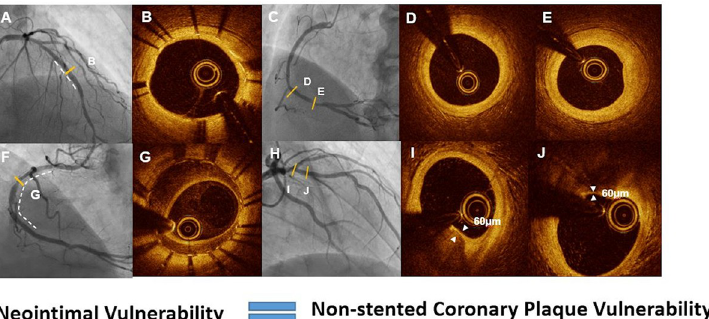
Fig 3. Association of in-stent neointimal patterns and native coronary plaque characteristics. Angiographic and optical coherence tomography images of the in-stent homogeneous neointimal pattern (A, B) and fibrous atherosclerotic plaque (C, D, E) and the in-stent heterogeneous neointimal pattern (F, G) and thin-cap fibroatheroma (H, I, J) in the native coronary artery.